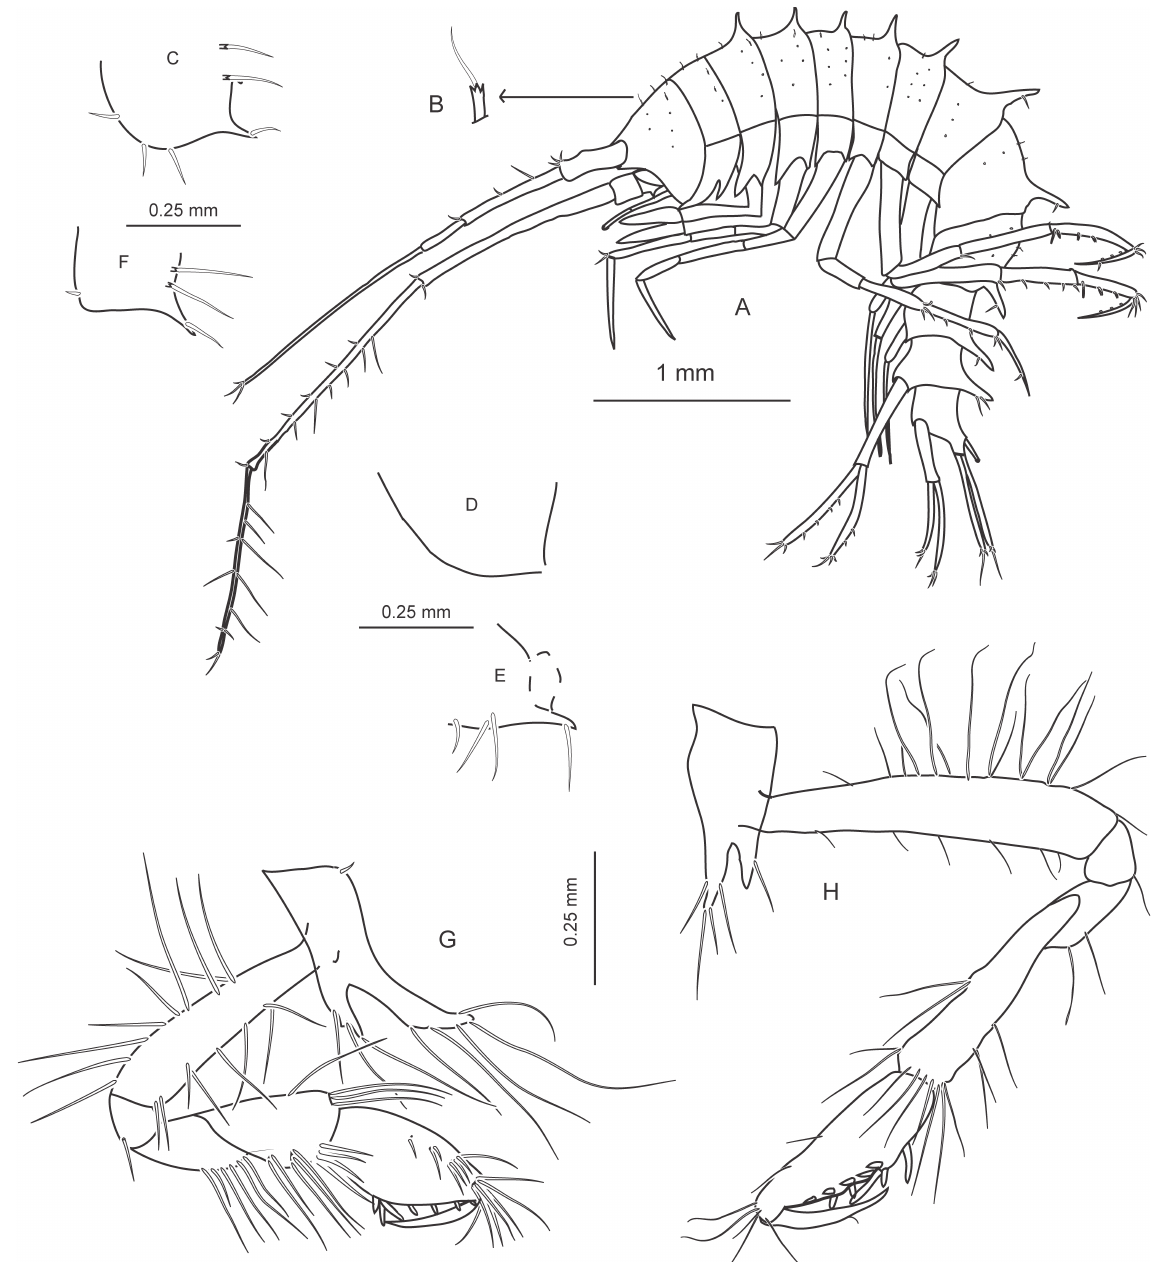
Fig. 17. Lepesubchela christinae gen. et sp. nov., holotype, immature. A . Habitus. B . Setae attached to crown-shaped peg. C . Left Ep1. D–E . Left and right Ep2. F . Left Ep3. G . Right Gn1. H .